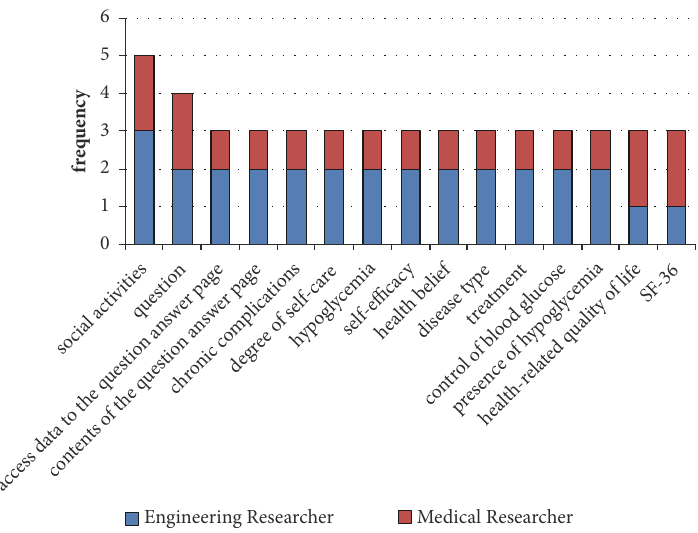
Figure 9: The frequency of VLs shared by more than two